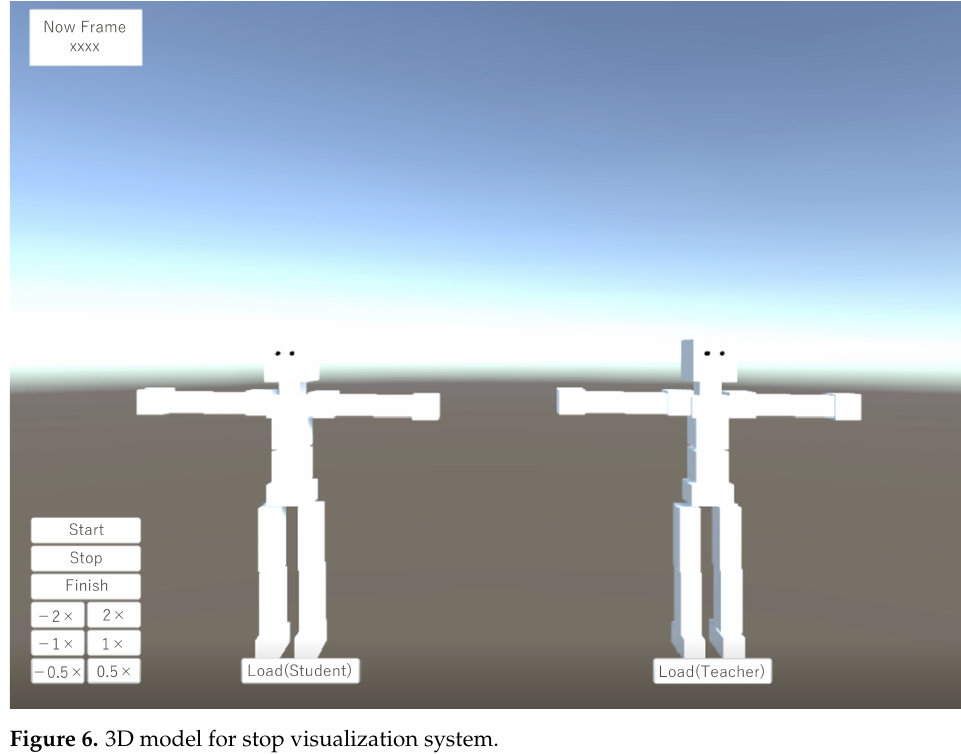
Figure 6. 3D model for stop visualization system.